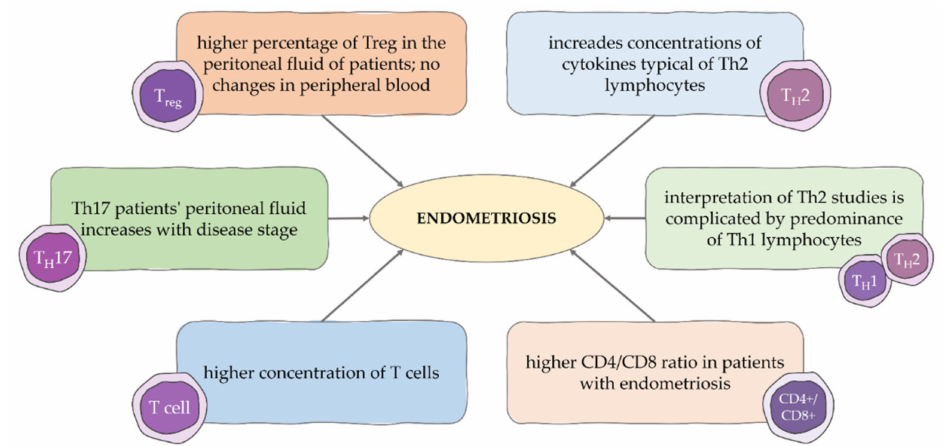
Figure 2. Participation of T cell subpopulation in the pathogenesis of